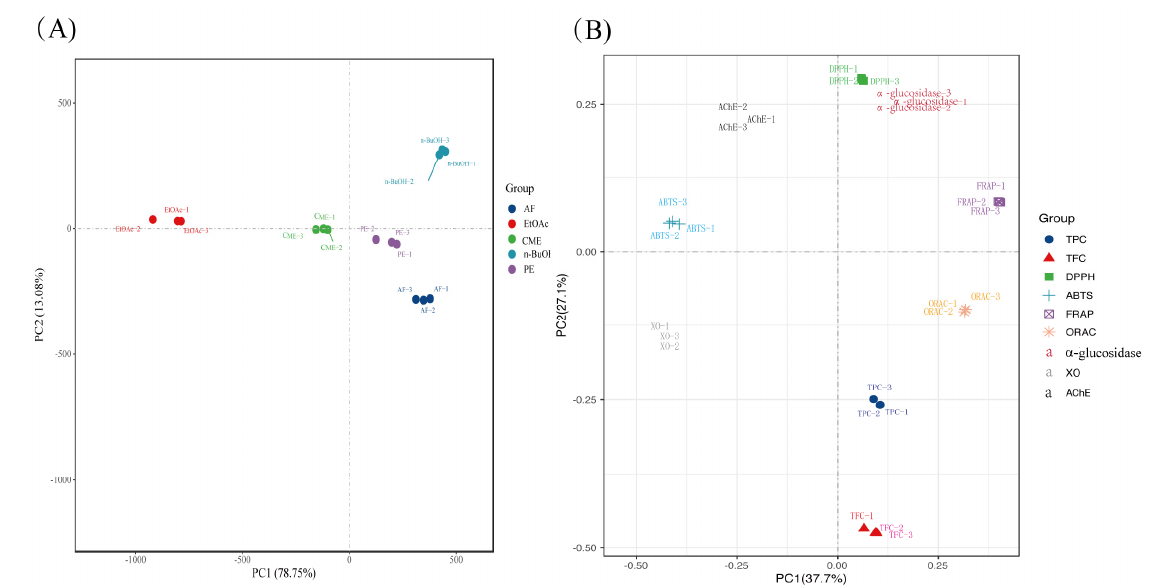
Figure 3. Principal component analysis (PCA) of different samples and indicators. ( A ) PCA of five M. lasiocarpa extract and fractions. ( B ) principal co-ordinates analysis (PCoA) of nine indicators of active ingredient content and biological activity. CME = crude methanol extract; PE =petroleum ether fraction; EtOAc = ethyl acetate fraction; n-BuOH= n-Butanol fraction; AF = aqueous fraction; TPC = total phenolic content; TFC = total flavonoid content; DPPH = DPPH · scavenging activity; ABTS = ABTS · + scavenging ability; FRAP = ferric reducing antioxidant power; ORAC = oxygen radical absorbance capacity; α -Glucosidase = the IC 50 value for α -glucosidase inhibitory activity; AChE = the IC 50 value for acetylcholinesterase inhibitory activity; and XO = the IC 50 value for xanthine oxidase inhibitory activity.